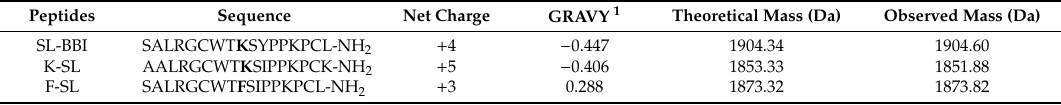
Table 1. Sequences and physicochemical properties of SL-BBI and its designed analogues.